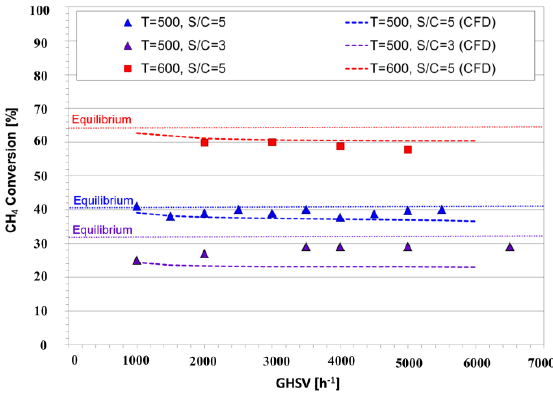
Figure 4. Experimental and computer simulation methane conversions in a packed bed reactor (PBR) as a function of different space velocities and conditions at a total pressure of 2 bar.